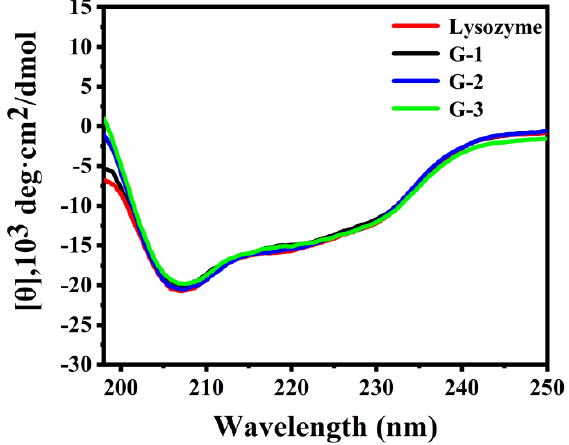
Figure 7. The CD spectra of the lysozyme: G-1, G-2 and G-3.